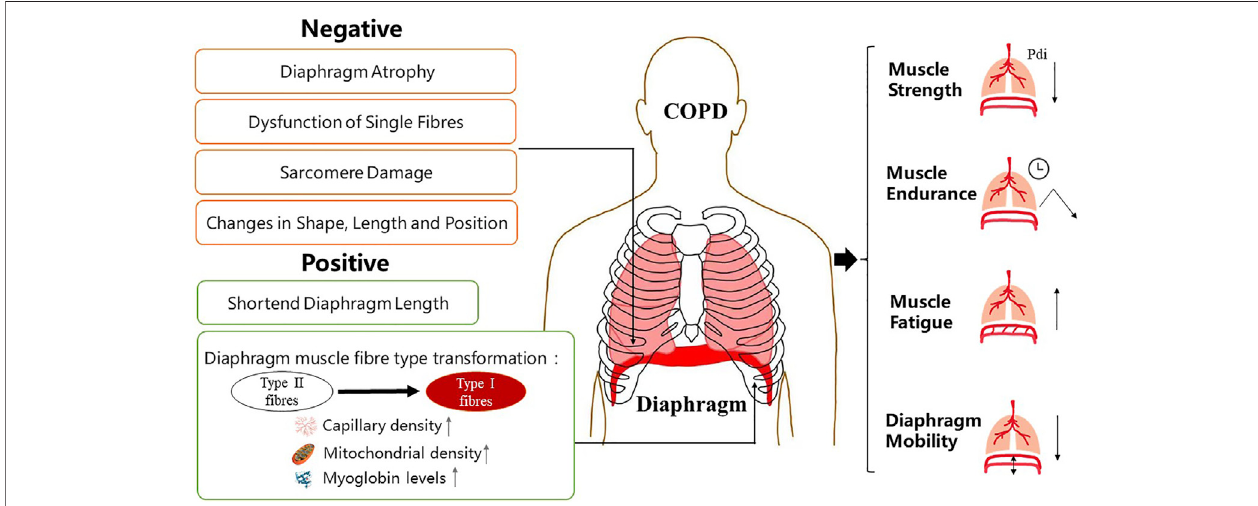
FIGURE 1 | Manifestations of diaphragm dysfunction in COPD. Diaphragm dysfunction in patients with COPD is mainly manifested in structural and functional changes. Changes in diaphragm structure include both negativeand positive changes. Thefunction ofdiaphragm depends largely on its physiologicalcharacteristics at the structural level. COPD, chronic obstructive pulmonary